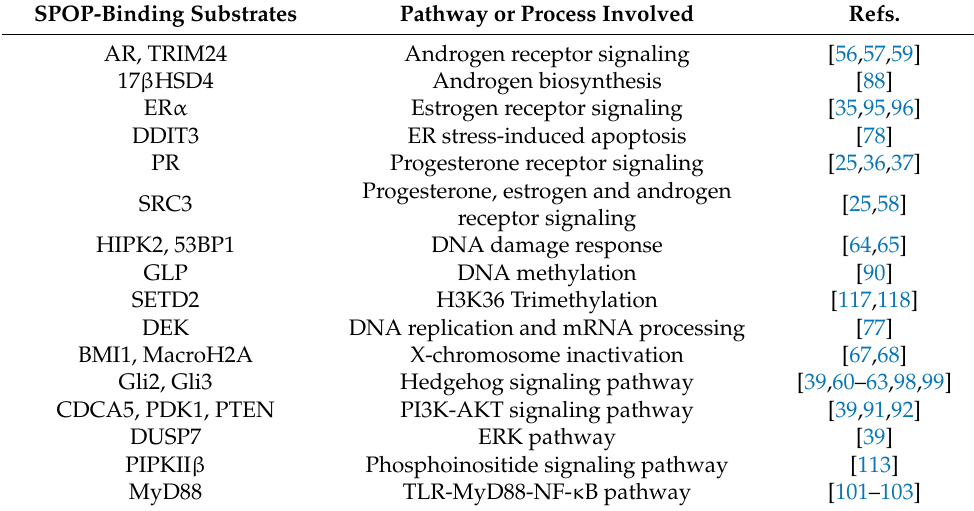
Table 1. Summary of SPOP substrates and their cellular functions. Androgen receptor—AR,